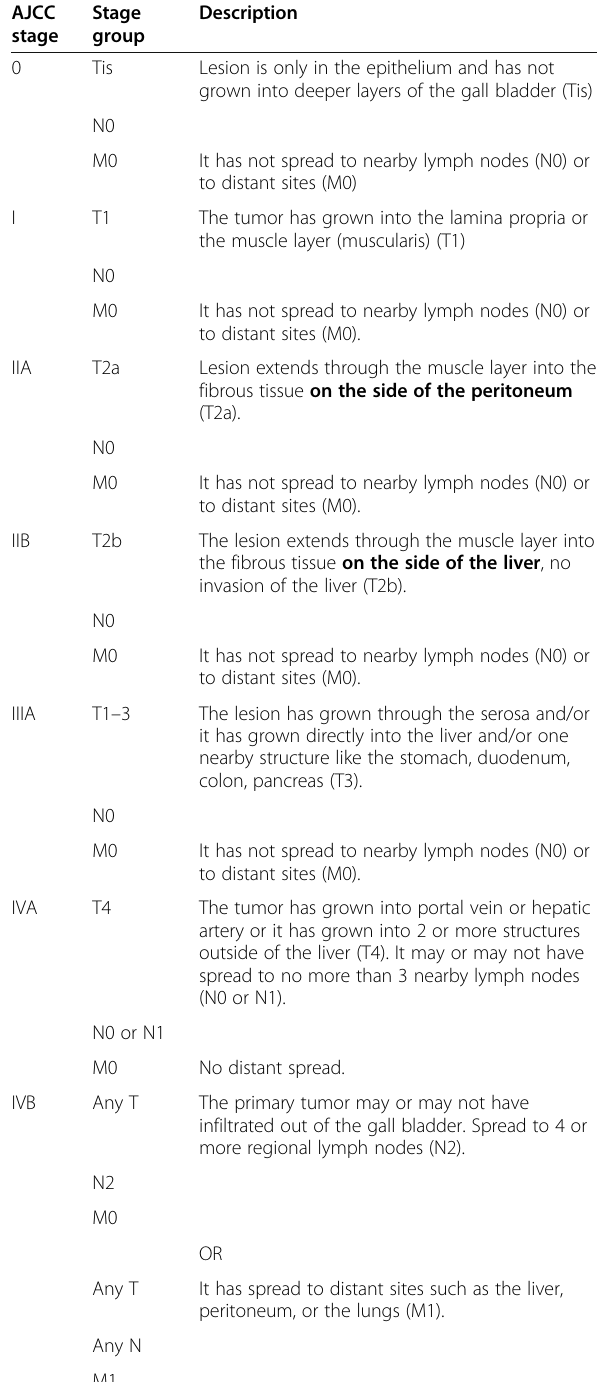
Table 1 AJCC stage AJCC staging system